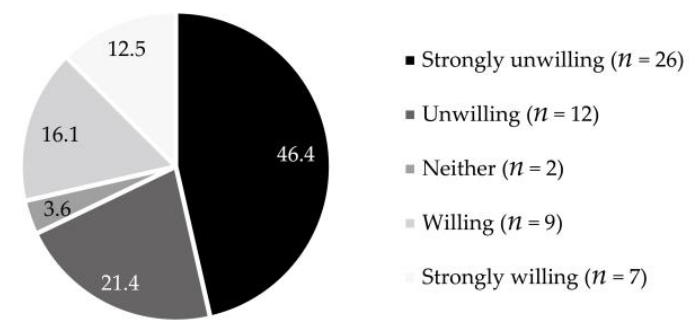
Figure 3. Willingness to use water cellars continuously ( n = 56).